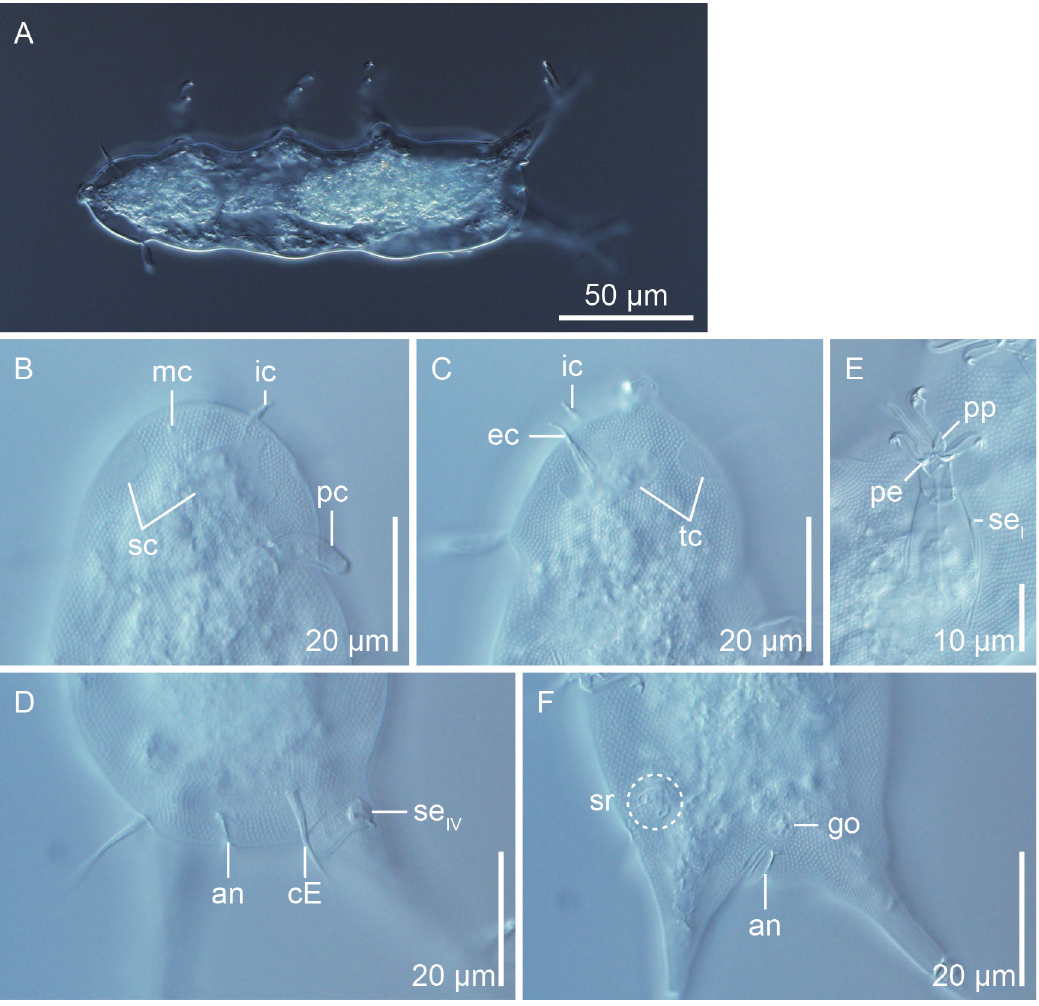
Fig. 7. Micrographs of Angursa seisuimaruae sp. nov. (KUZ Z2066). A . Habitus. B . Cephalic region (dorsal). C . Cephalic region (ventral). D . Caudal region (dorsal). E . Leg I. F . Caudal region